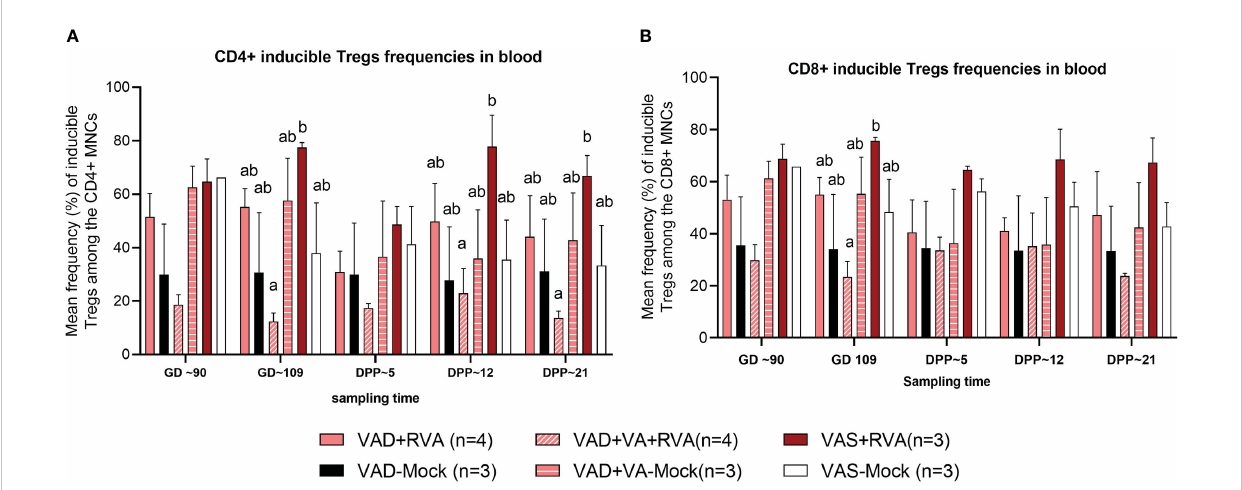
FIGURE 6 Analysis of CD4 + and CD8 + inducible regulatory T cells in blood using fl ow cytometry. (A) Mean frequencies of CD4 + inducible among the CD4 + T cells in blood mononuclear cells. (B) Mean frequencies of CD8 + inducible among the CD8 + T cells in blood mononuclear cells. Letters a and b indicate signi fi cant differences among treatment groups (mean ± SEM) at each time point. Statistical analysis was performed using two-way ANOVA with repeated measures and Tukey-Kramer test for multiple comparisons, P ≤ 0.05. (GD, gestation day; DPP, day post-partum; VAD, vitamin A de fi ciency; VAS, Vitamin A suf fi cient; VA-vitamin